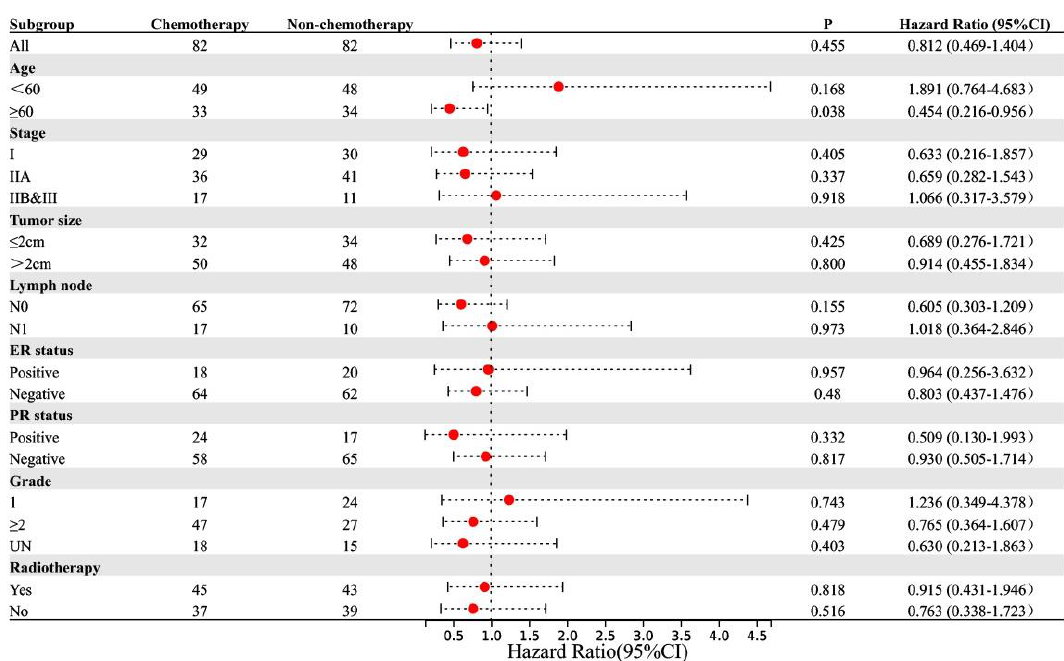
Figure 3. Subgroup analysis of OS in chemotherapy and non-chemotherapy groups .